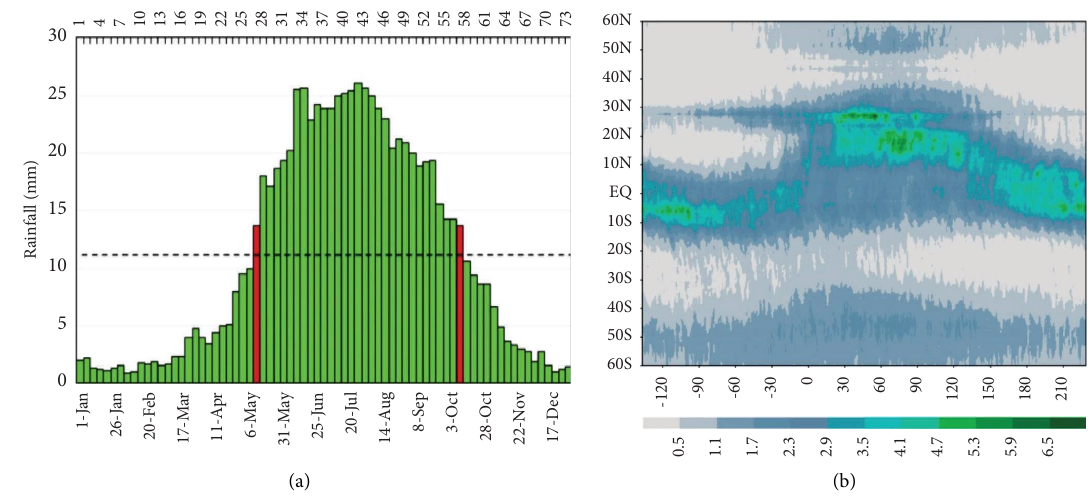
Figure 7: (a) Te climatological pentad precipitation of southwest monsoon over Myanmar based on ERA5 data. Te horizontal dashed line denotes the annual mean pentad precipitation (Pm) defned in the text. (b) Seasonal evolution (day of the year) of precipitation (mm · day − 1 ) averaged over 90–105 ° E: based on GCPC data during (Jan 1st, 1991–Dec 31st,